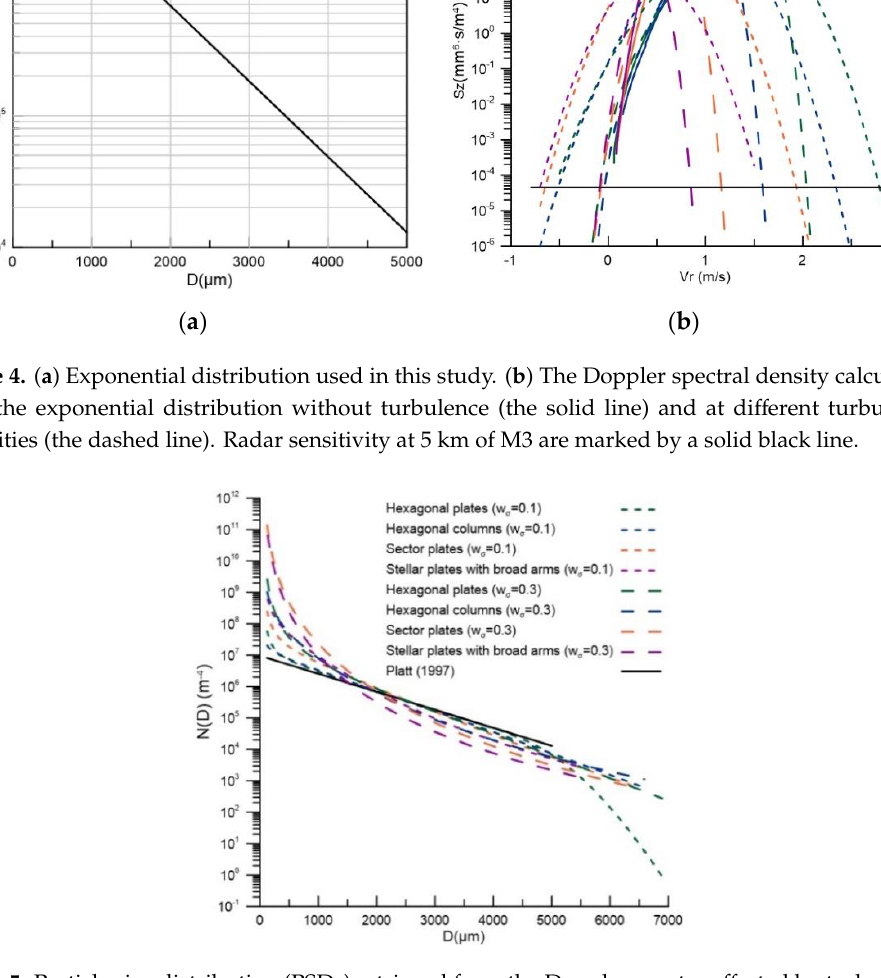
Figure 5. Particle size distribution (PSDs) retrieved from the Doppler spectra affected by turbulence, shown in Figure 4b. The solid black line is the PSD given by Platt (1997) at −10 °C~−5 °C (same as Figure 4a).